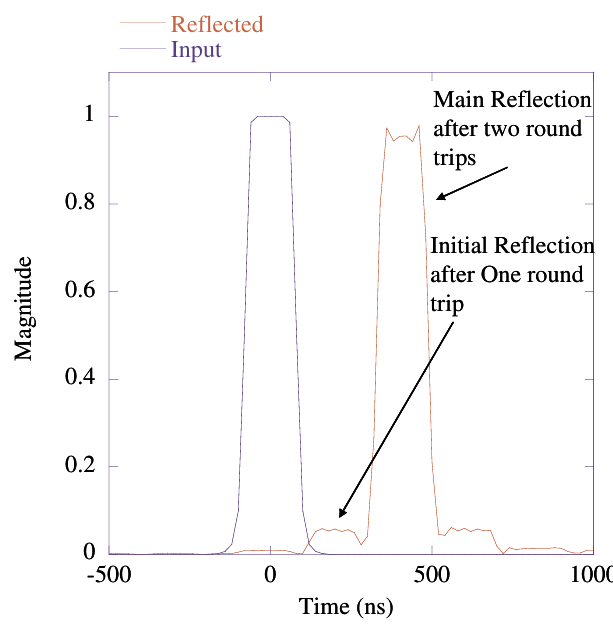
FIG. 17. (Color) A typical top delay line response without an input iris.